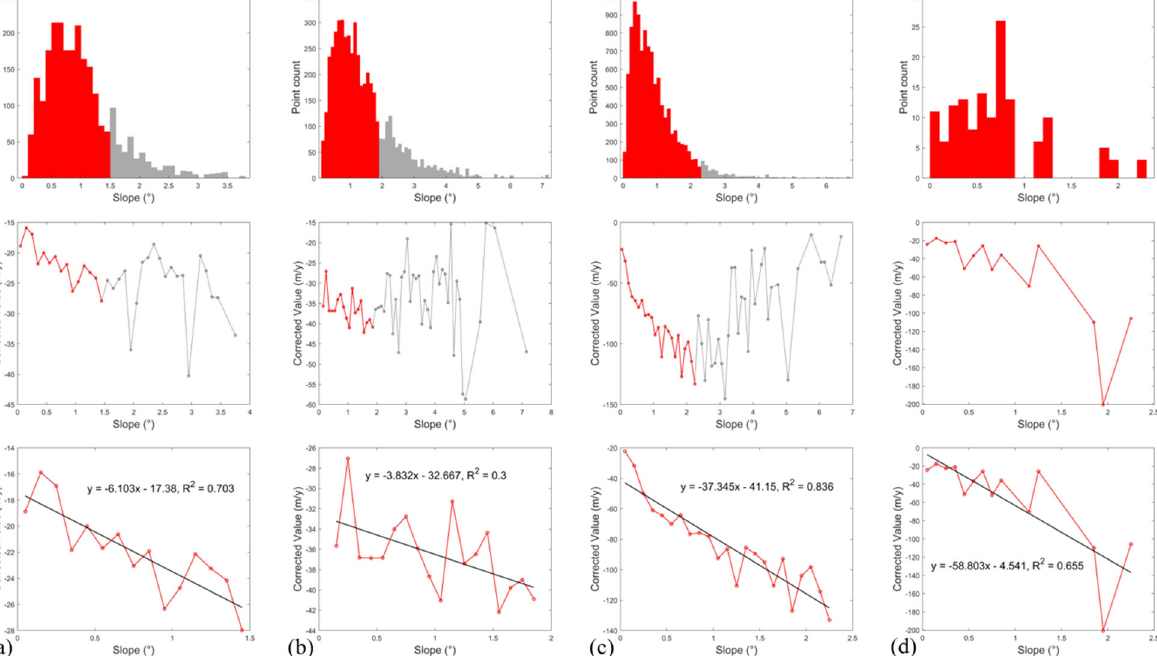
Figure 7 . The relationship between corrected values and the slope of velocity field (a) without GL0’25 km buffer and in inland (Sub- region 1), (b) within GL0’25 km buffer and in inland (Sub-region 2), (c) within GL0’25 km buffer and in ice shelf (Sub-region 3), (d) without GL0’25 km buffer and in ice shelf (Sub-region